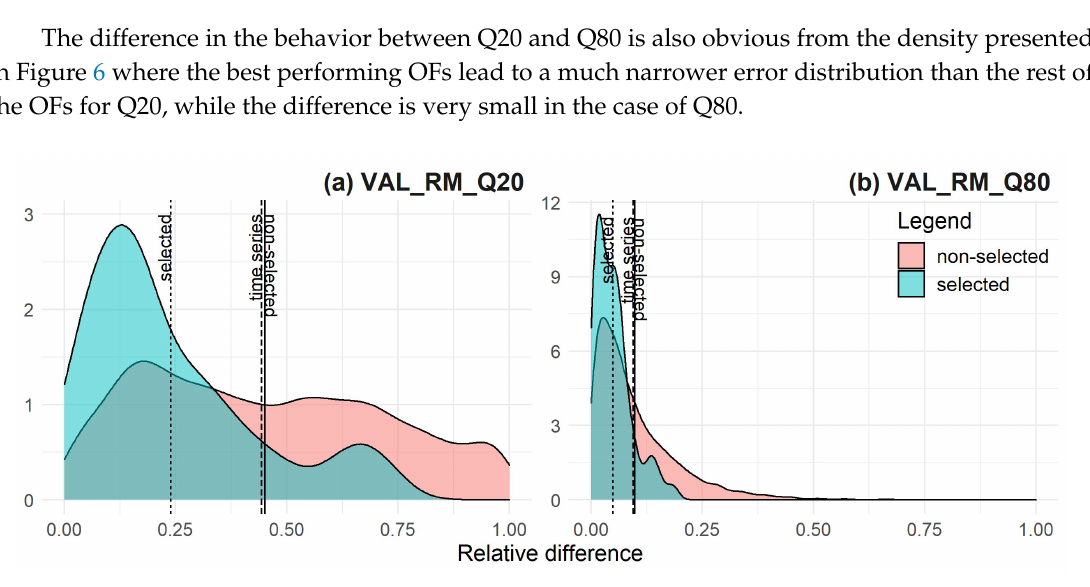
Figure 6. Density of error in runoff signatures in Q20 ( a ) and Q80 ( b ) based on selected best-performing OFs (green area) and the rest (red area). Dotted line correspond to mean of selected best-performing objective functions, dashed line to mean OFs including time series and the solid line the mean of the OFs that were not